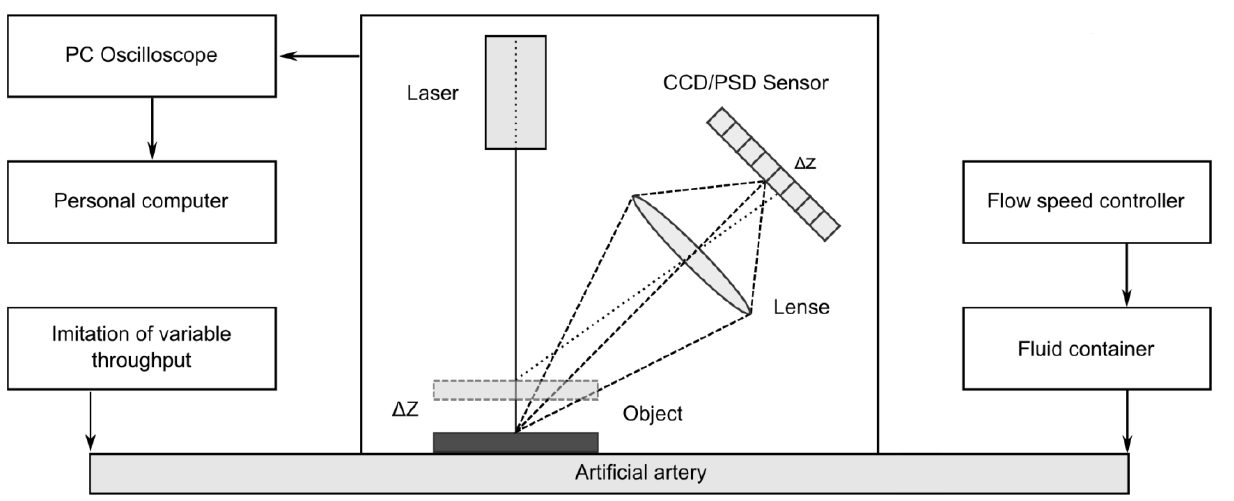
Figure 4. Scheme for measurement of artificial radial pulses by means of laser triangulation